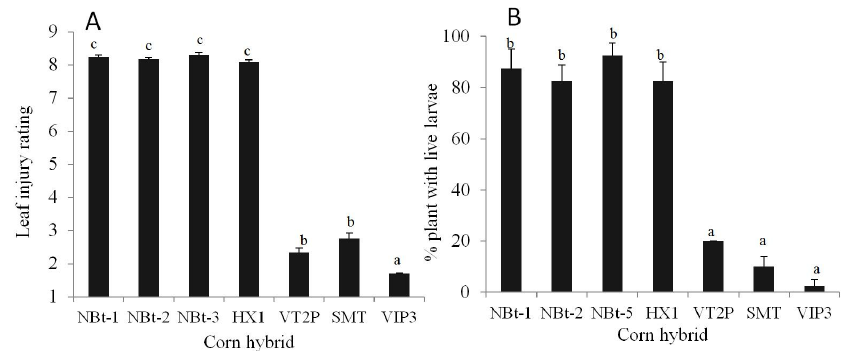
Figure 1. Leaf injury ratings (A) and occurrence of feral populations of Spodopterafrugiperda (B) on non-Bt and Bt maize containing single and pyramided genes in a field trial in 2013 in Collier Co., Florida. Leaf injury ratings were measured at V9–V12 plant stages using Davis’s 1–9 scale 17 , while larval occurrence was recorded at R1 plant stage. NBt-1, Pioneer 31P40; NBt-2, DKC 61-22; NBt-5, N78N-GT; HX1, Pioneer 31D59; VT2P, DKC 61-49; SMT, DKC 62-08; VIP3, N78N-3111. Bars represent means ( 6 SEM) and those with a common letter were not significantly different at a =0.05 (Tukey’s HSD test).